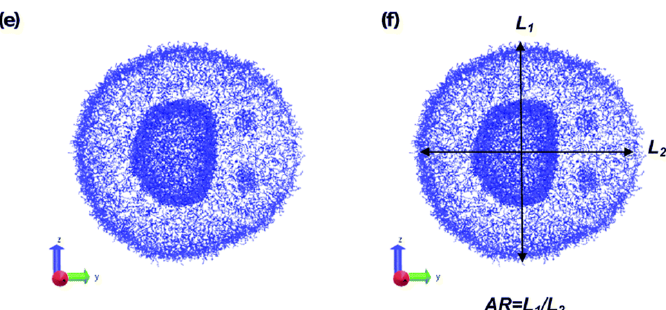
Figure 8. Microinjection of a droplet of SB that is 8.07% of the vesicle volume (15,584 beads) near the surface of the vesicle at ( a ) t = 0, ( b ) t = 200, ( c ) t = 500 and ( d ) t = 5000. The polymer A block is shown in blue, SB is coloured red and the polymer B block and SA beads are not shown. Panel ( e ) shows t = 500 again, omitting SB to highlight the flattening of the lumen wall and the formation of a micelle in the inner membrane. Panel ( f ) defines the aspect ratio (AR) as the ratio between the spans in the z -direction and the y -direction. (Republished with permission of Royal Society of Chemistry, from Q.Y. Zhu, T.R. Scott, D.R. Tree, Using reactive dissipative particle dynamics to understand local shape manipulation of polymer vesicles. Soft Matter 2021 , 17 , doi:10.1039/d0sm01654c; Copyright 2021; permission conveyed through Copyright Clearance Center, Inc.).